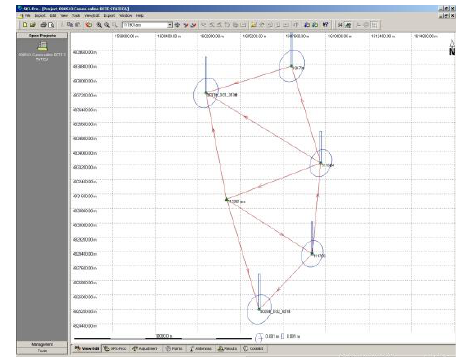
Figure 10. GPS network